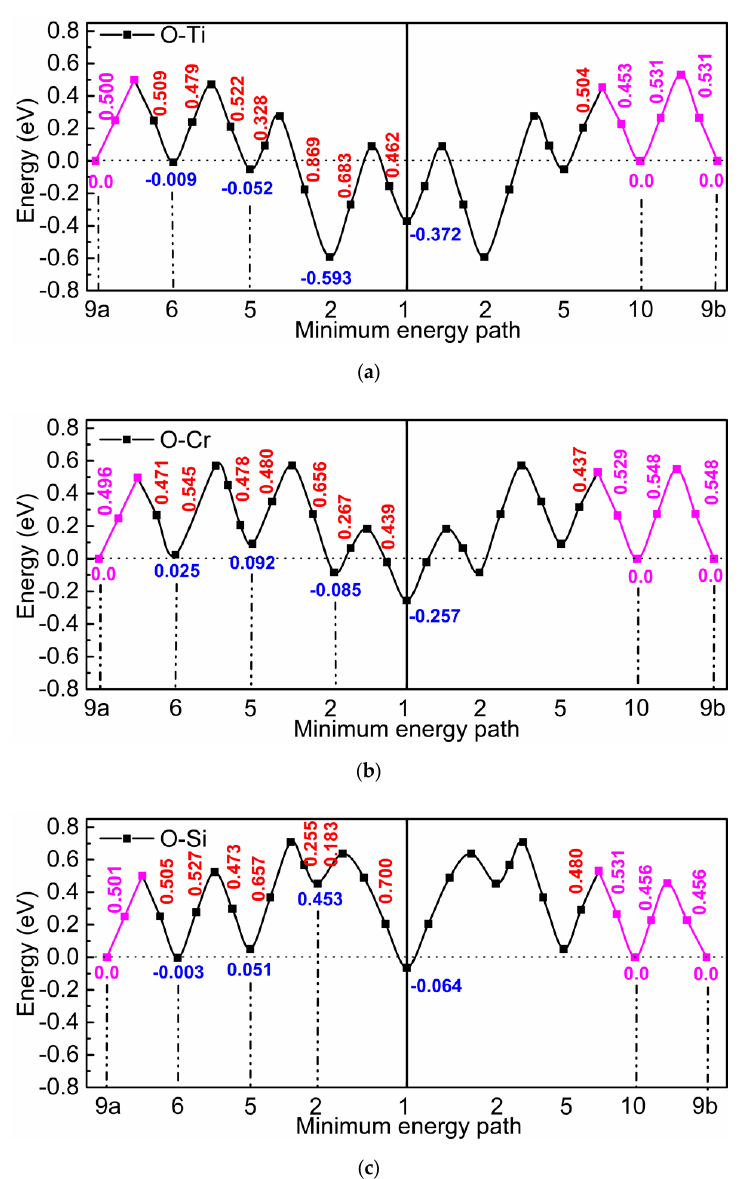
Figure 2. Migration barriers for oxygen in the environment of Ti ( a ), Cr ( b ), and Si ( c ). The red and blue numbers show the barrier height and the binding energy, respectively. The magenta lines and numbers show modifications of the original Density-Functional-Theory (DFT) data according to the rule of detailed balance (see